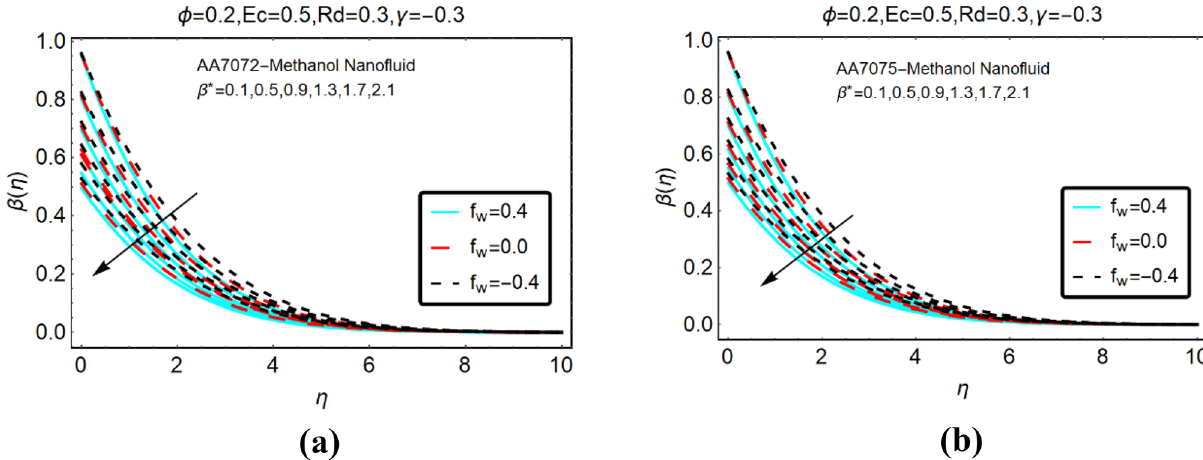
Figure 7. The effects of β ∗ on β(η) ( a ) AA7072-Methanol ( b ) AA7075-Methanol for heat absorption.